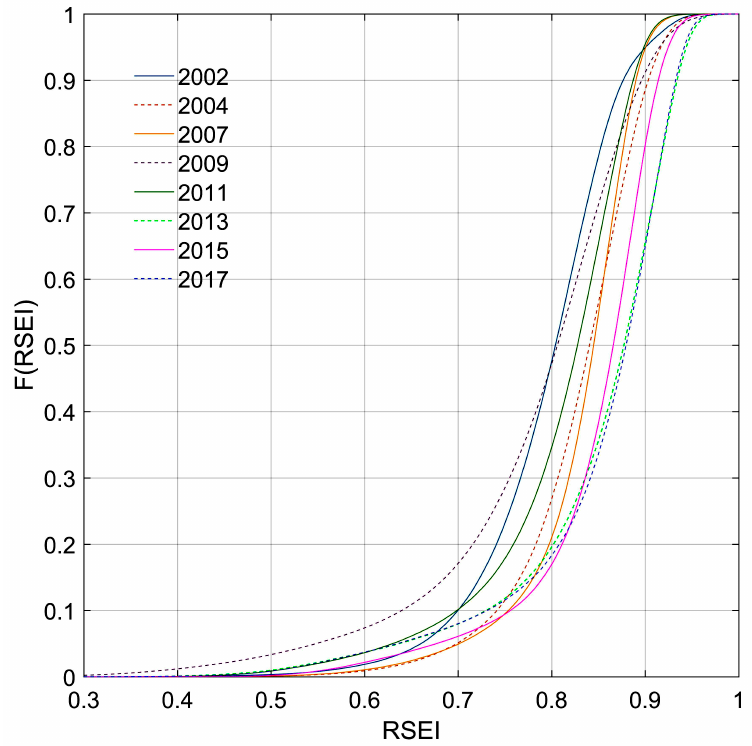
Figure 4. Illustration of the empirical cumulative distribution functions (ECDF) of RSEI of each study year.